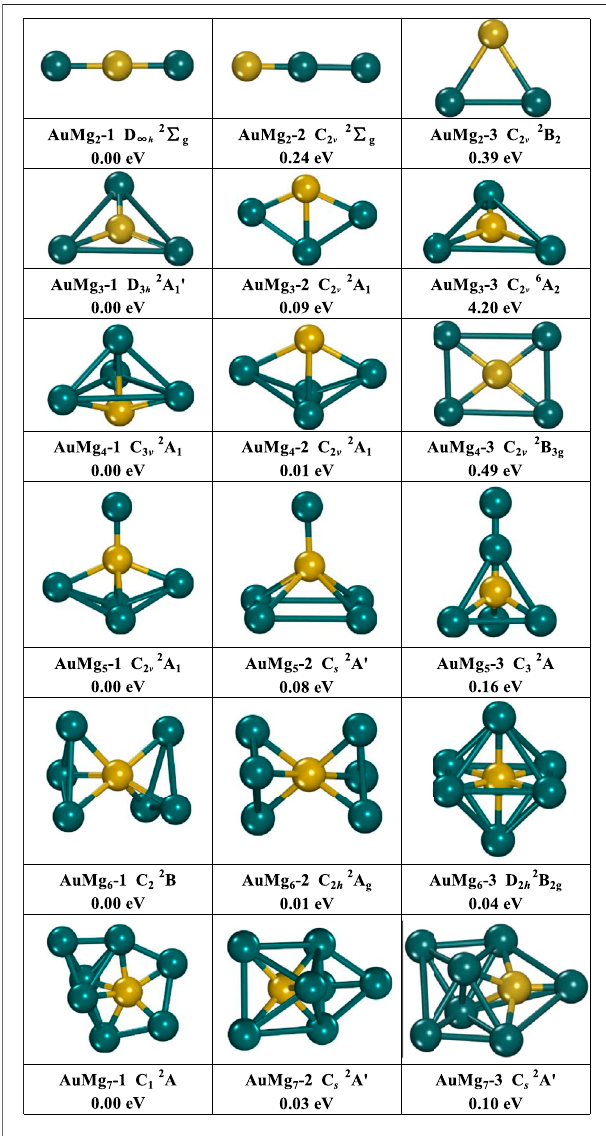
FIGURE 1 | The geometry of the three lowest energy isomers of AuMg n ( n = 2 – 7) nanoclusters, energy difference in eV from the lowest energy isomer at the same